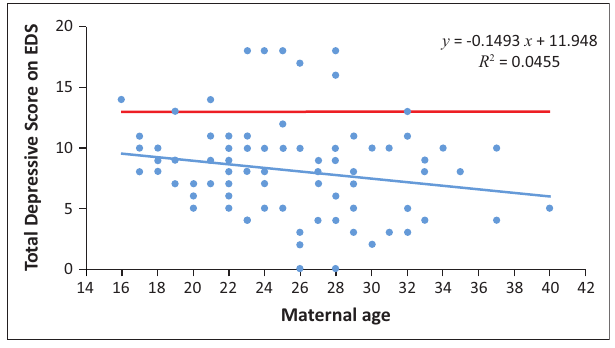
FIGURE 2: Depressive scores of HIV-infected versus HIV-uninfected pregnant women. Results are presented as mean ± standard deviations.